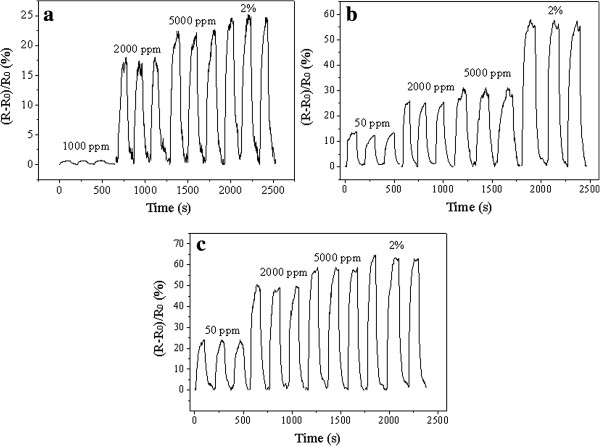
Response curves of the Ni-doped TiO2 sensor exposed to various hydrogen concentrations. (a) 25°C (b) 100°C, and (c) 200°C.